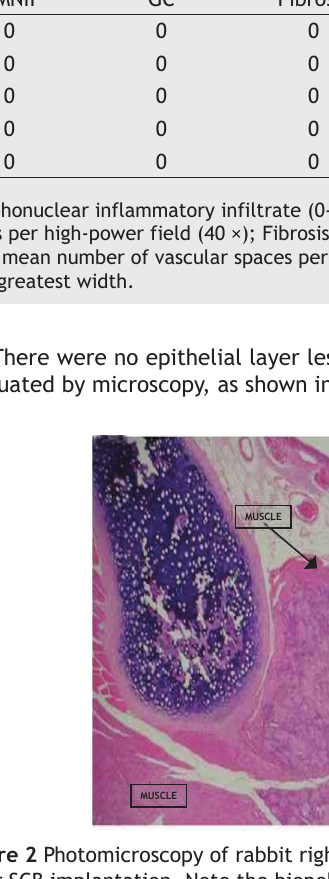
Table 4 Histological characteristics found in Group II - 90 days - Control vocal fold. Rabbit